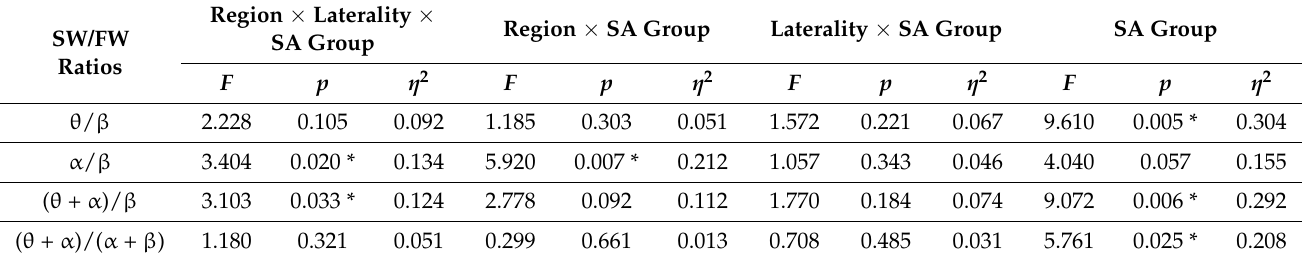
Table 3. ANOVA results of SW/FW ratios for the two SA groups.